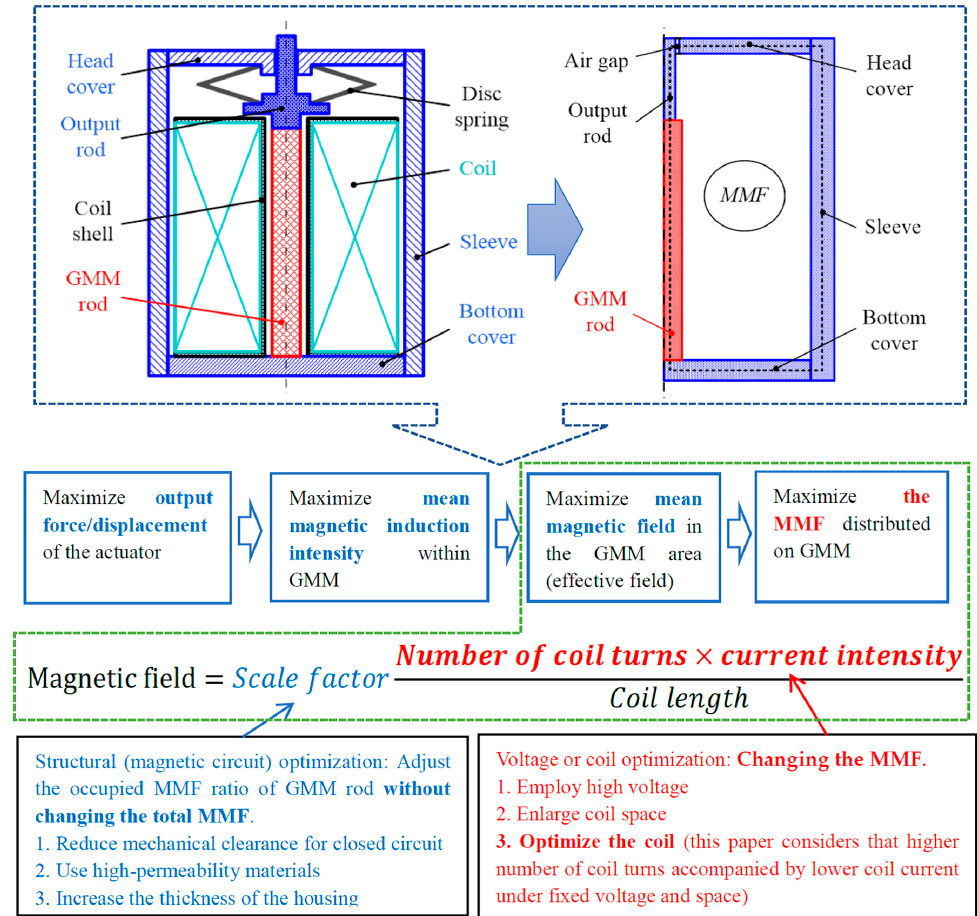
Figure 1. Generally used optimization methods for the giant magnetostrictive actuator: Refs. [16 – 31] based on the first method and Refs. [36 – 44] based on the second one.